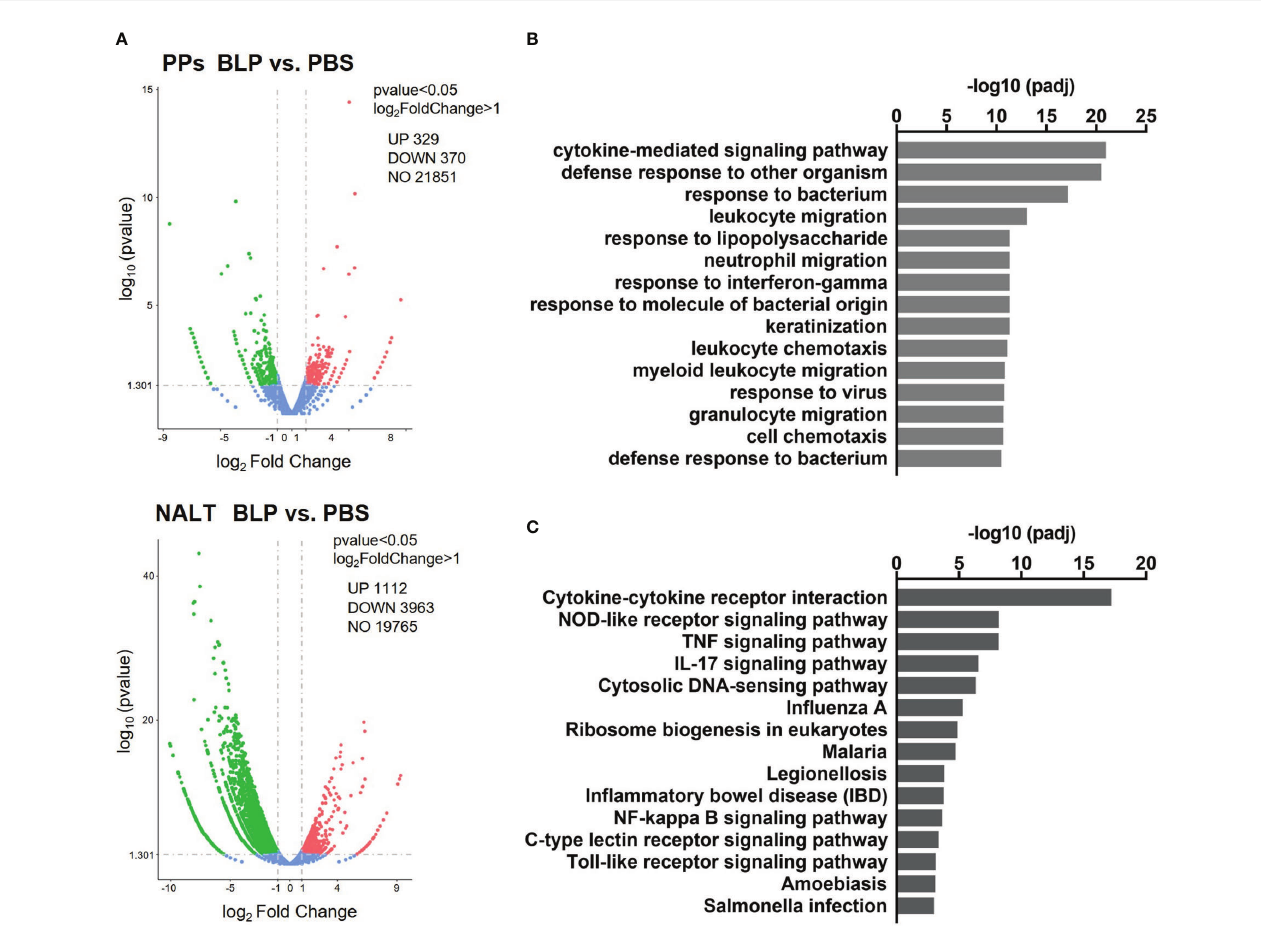
FIGURE 5 Transcriptome analysis of the mucosal lymphoid tissues. Mice were administered orally or nasally with BLP-Tir or PBS. RNA-seq analysis was performed using total RNA extracted from the PPs of orally administered mice and from the NALT of nasally administered mice at 6 h post-administration (n=1). (A) Volcano plots represent DEGs between the PPs (upper) and the NALT (bottom) of PBS and BLP-Tir administered mice. (B) Gene ontology (GO) and (C) , KEGG pathway analysis of genes upregulated in the NALT of BLP-Tir administered mice compared with those of the PBS administered